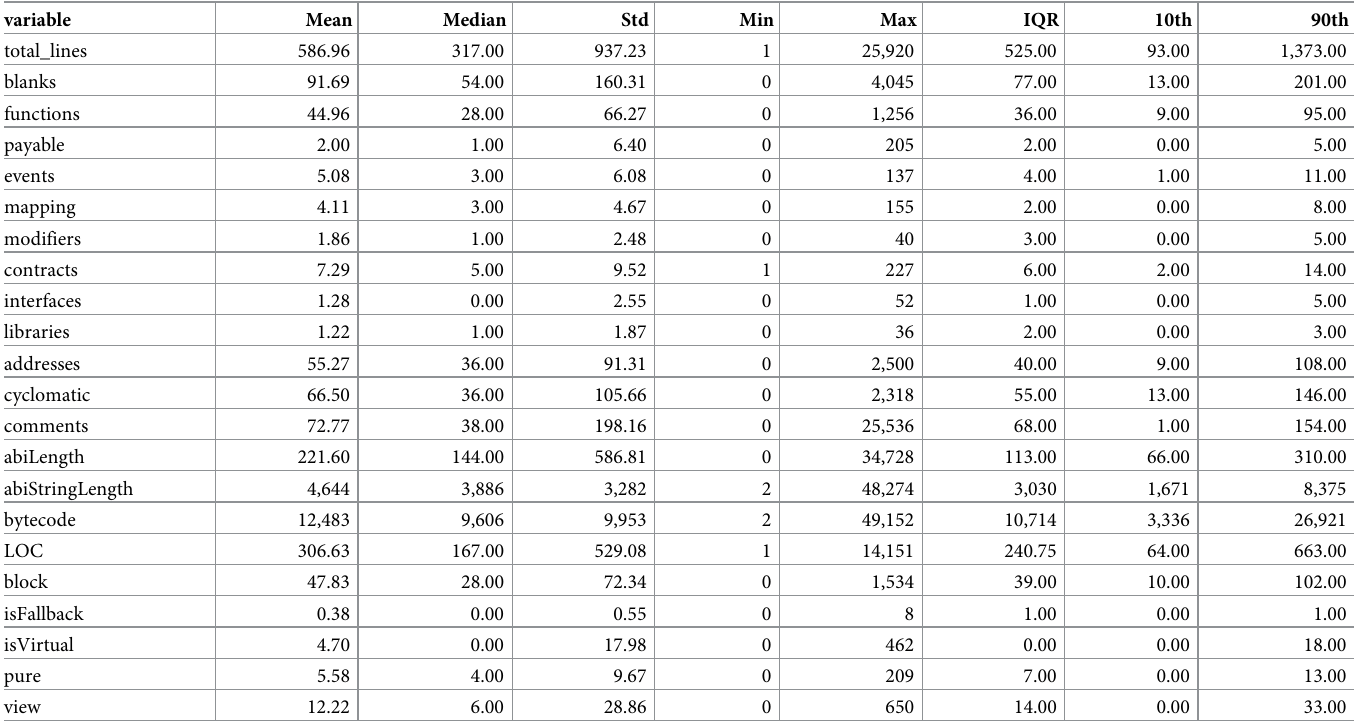
Table 1. Centrality and dispersion statistics computed for all the Smart Contract software